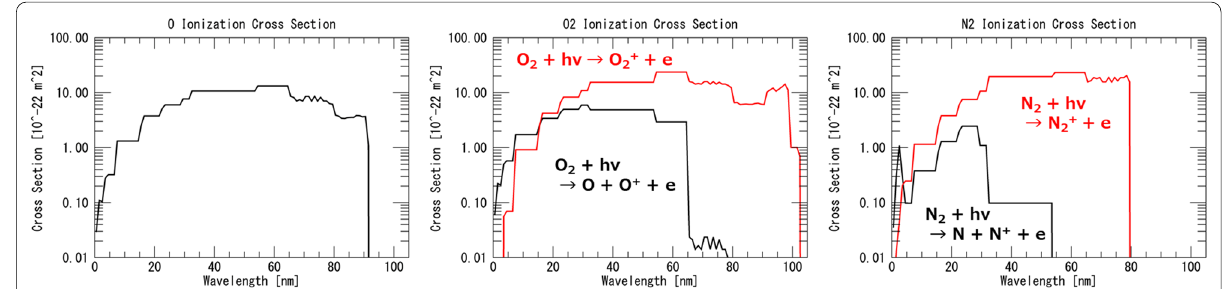
Fig. 5 Photoionization and photo-dissociative ionization cross sections of major solar atmosphere atoms and molecules. Photoionization and photo-dissociative ionization cross sections for each wavelength. (Left) Photoionization cross section of oxygen atom, (middle) cross section of photoionization and photo-dissociative ionization of oxygen molecule, and (right) photoionization and photodissociation of nitrogen molecule. Cross-section data are based on Solomon and Qian (2005)